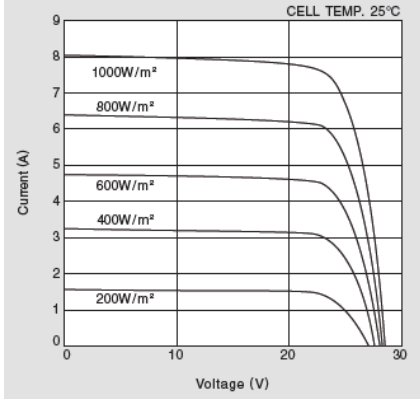
Figure 5. Characteristic of the chosen PV module.